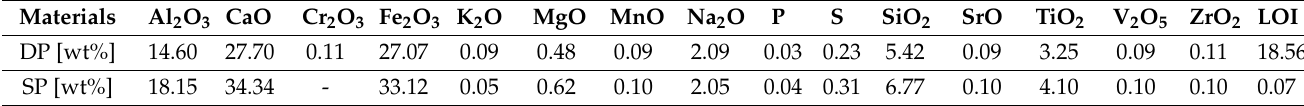
Table 2. XRF results for dried pellets (DP) and sintered pellets (SP).